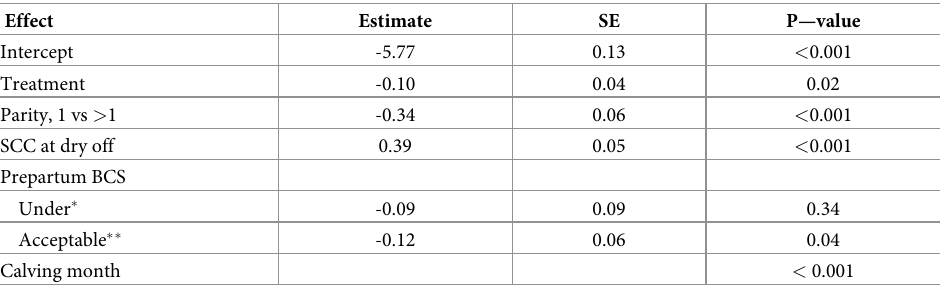
Table 4. Rate of total cases of clinical mastitis per cow-day at risk during the full